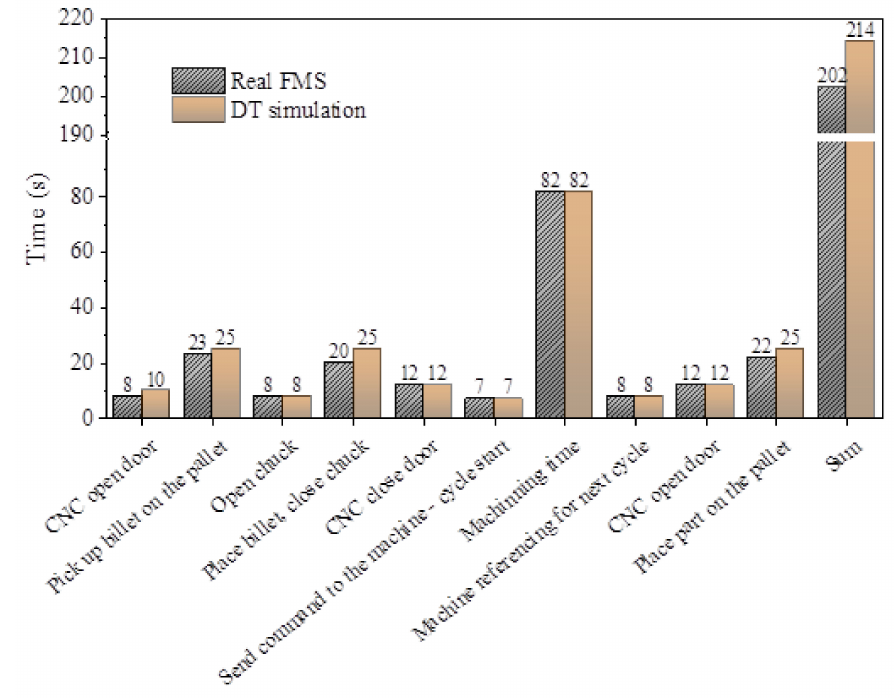
Figure 8. FMS manufacturing and DT simulation